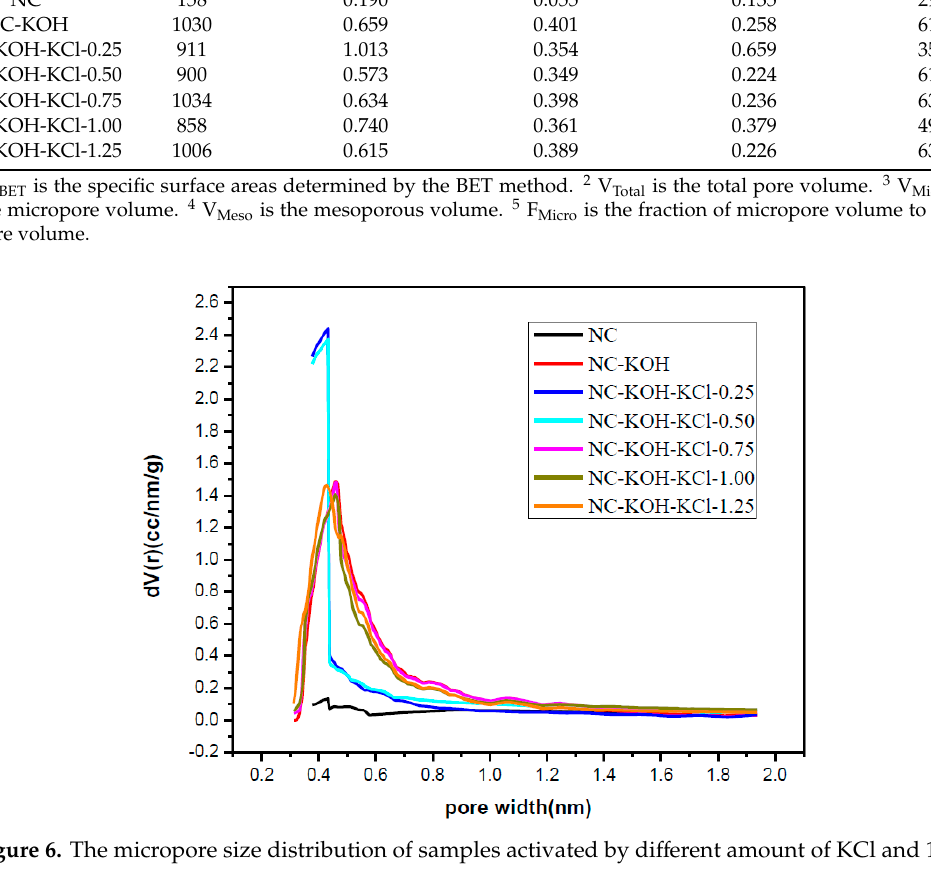
Table 3. The content of N, C, H and O in samples carbonized at different temperatures.